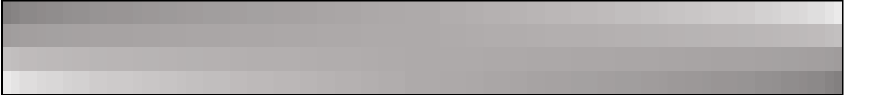
Figure 2. Graphical representation of the probability mass distribution of Hassall’s algorithm as a heat map, where a probability of one gives black values and zero white values.